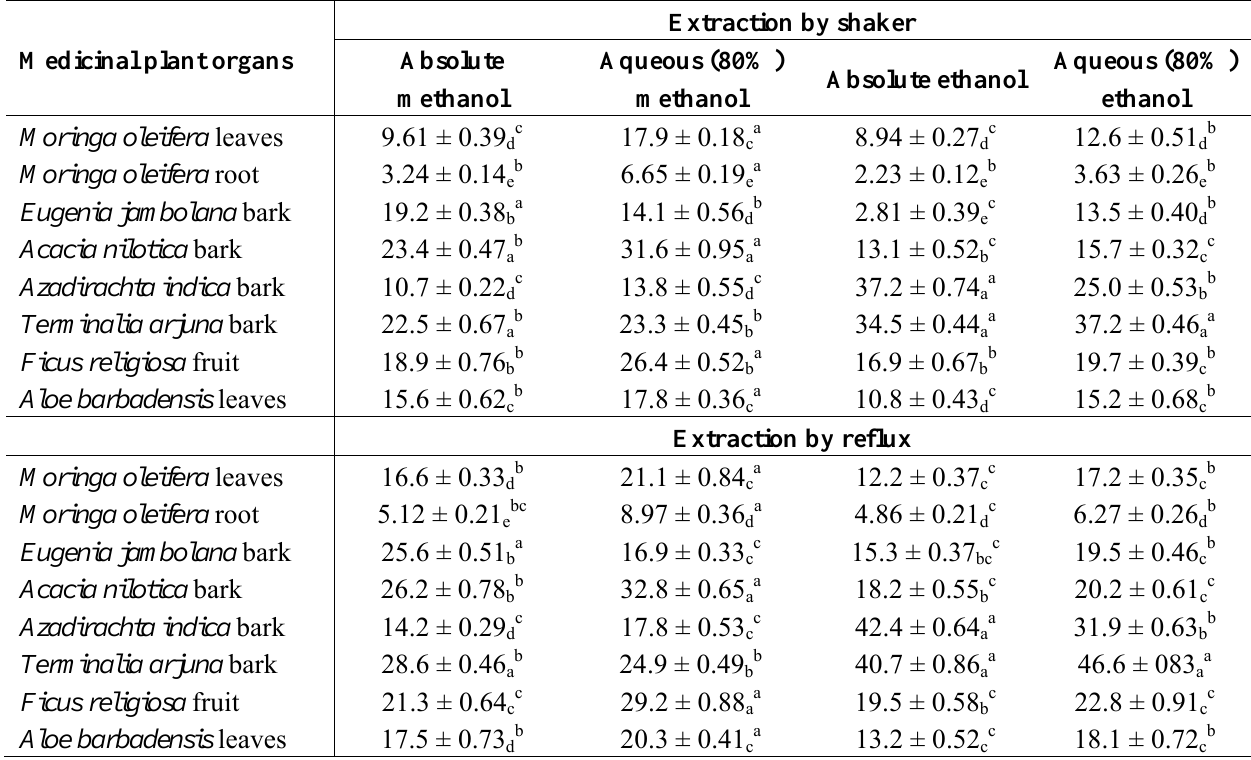
Table 1. Effects of extracting solvent/technique on the extract yield (g/100 g of DW) of medicinal plant